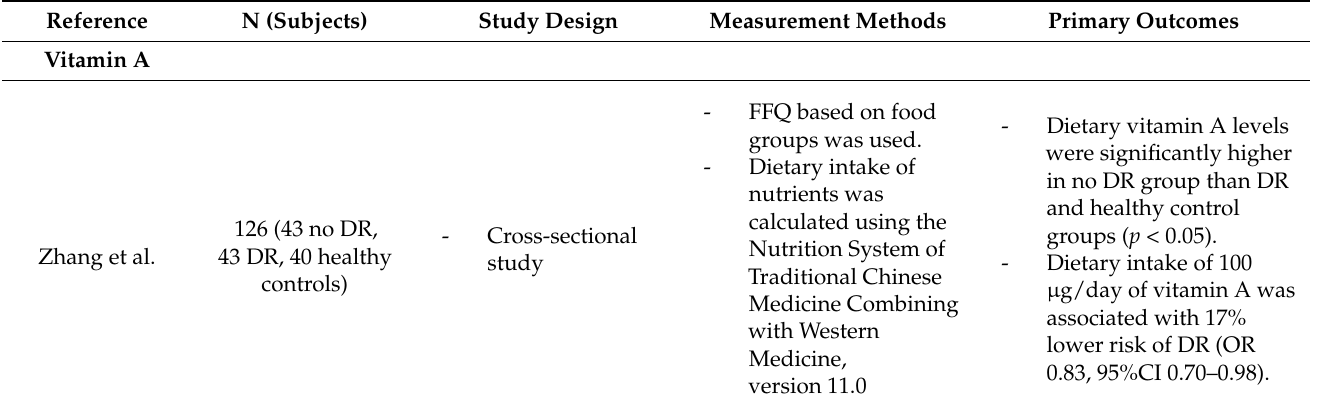
Table 2. Studies on associations between dietary intakes of vitamins and diabetic